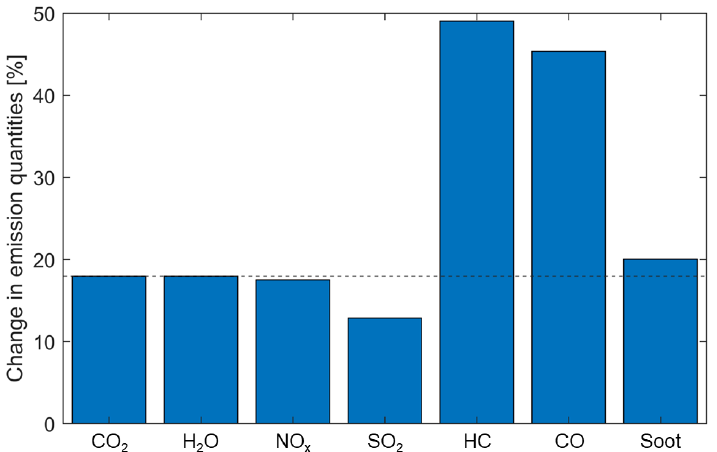
Figure 4. Relative increase in emission quantities for climate-optimised ISO compared to the non-stop reference case, additional relative fuel consumption of 17.96% is indicated by the dashed line as a